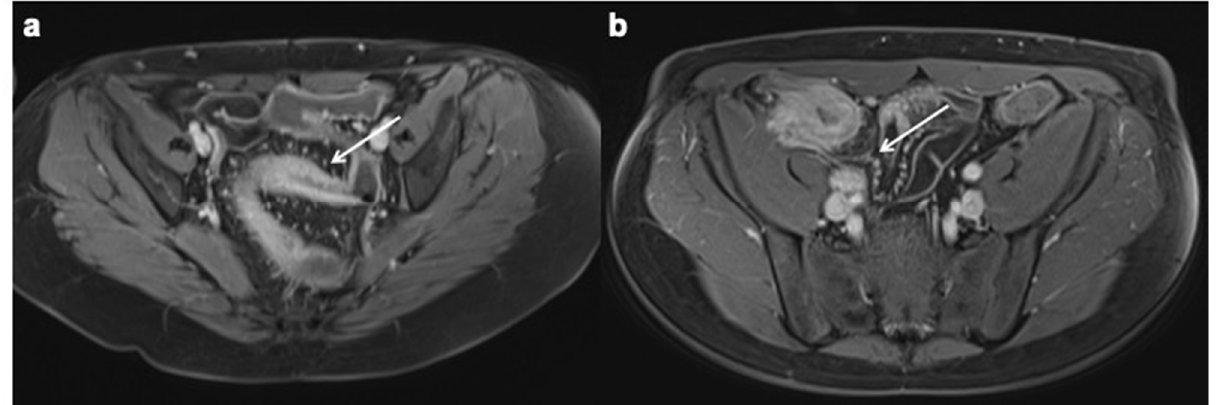
Figure 7. Engorged vasa recta. Axial contrast-enhanced fat-suppressed T1 weighted portal venous phase ( a , b ) MRE images show engorged vasa recta (white arrows) in the small bowel mesentery owing to active inflammatory CD.